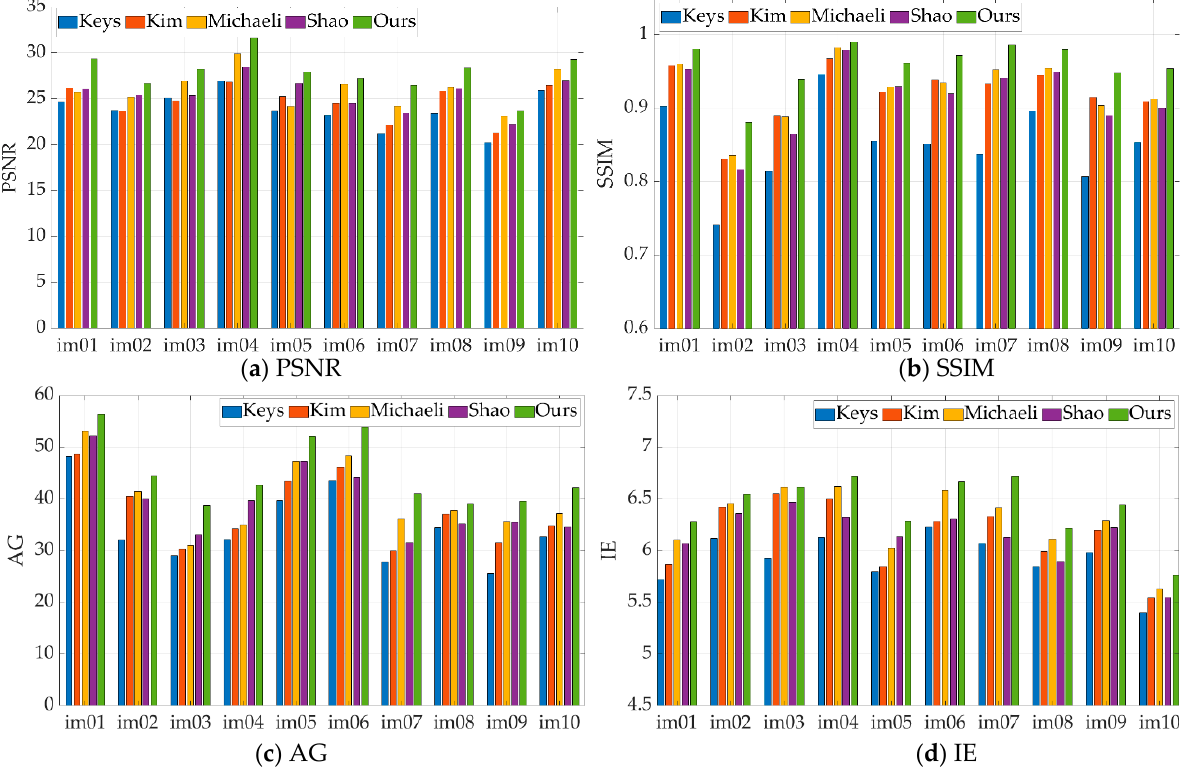
Figure 5. Using 5 × 5 Gaussian blur kernel, PSNR, SSIM, AG and IE parameter values of reconstruction results of different methods: ( a ) PSNR value; ( b ) SSIM value; ( c ) AG value; ( d ) IE value.